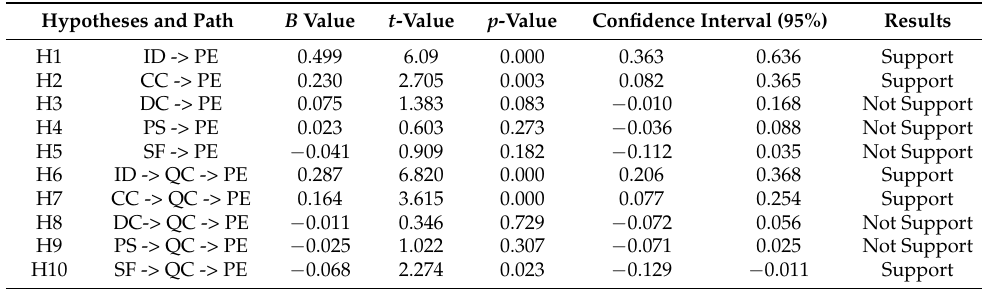
Table 4. Summary of hypotheses